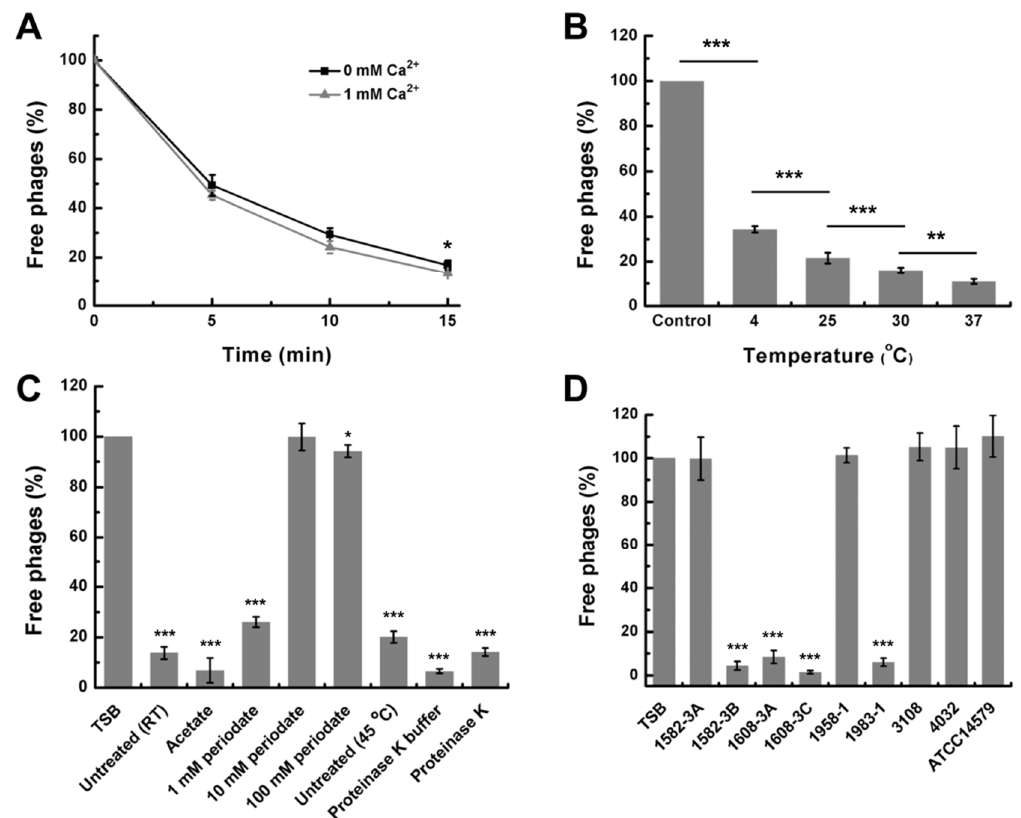
Figure 9. Adsorption assay of DLc1. ( A ) Amount of adsorption during 15 min using 1582-3B as the host at 37 °C; ( B ) Adsorption of DLc1 to 1582-3B at different temperatures for 15 min; ( C ) Adsorption of DLc1 to 1582-3B after different treatments on the host cells (statistical significance is done by comparing the value of each group with the TSB group); ( D ) Adsorption of DLc1 to different strains (statistical significance is done by comparing the value of each group with the TSB group). ( C ) and ( D ) were both conducted at 37 °C for 15 min. All data present the means and standard deviations (SD) of three independent assays. Asterisks indicate significant differences (** p ≤ 0.01, and *** p ≤ 0.001). To test which kinds of receptors on the cell surface can be recognized by DLc1, B. cereus 1582-3B